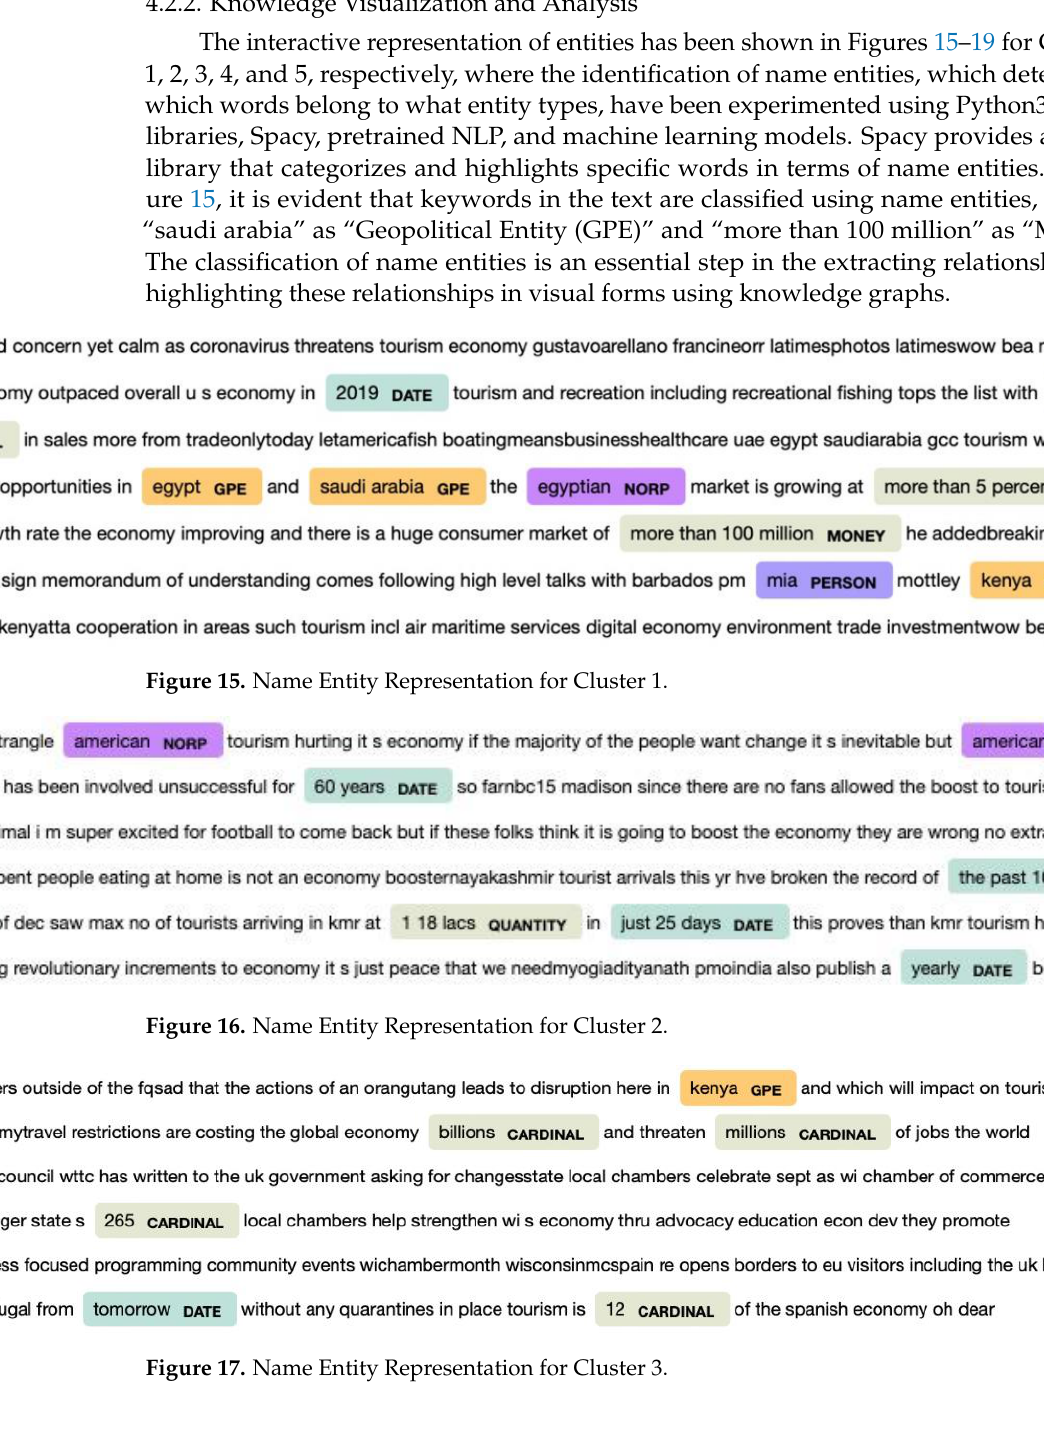
Figure 17. Name Entity Representation for Cluster 3.